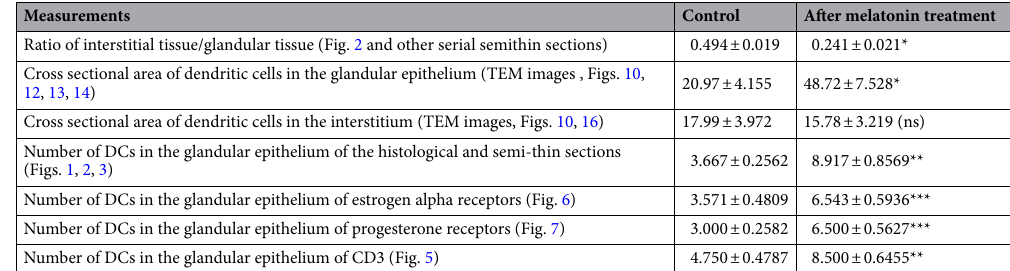
Table 2. The morphometric measurements of the control and melatonin treated groups. The measurements are expressed as the mean ± SE. When P < 0.05 (*) is significant, P < 0.01 (**) and P < 0.01 (***) is highly significant.